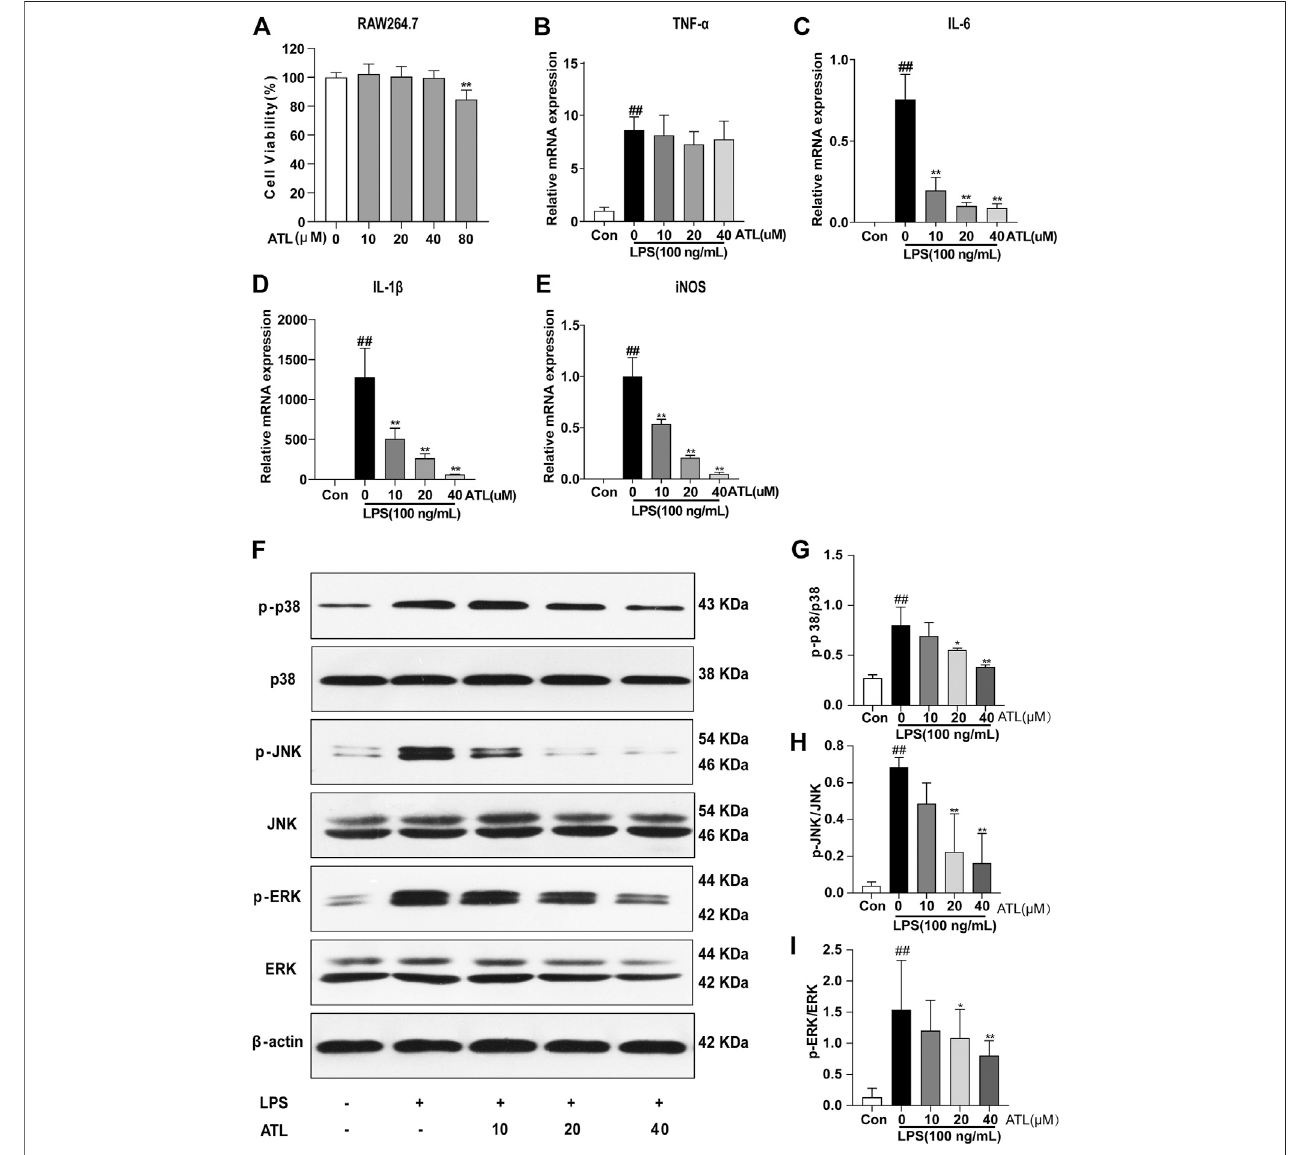
FIGURE 4 | ATL can inhibit the MAPK pathway and expression of in fl ammatory factors in macrophages (A) Cell viability of RAW264.7 cells treated without or with different concentrations of ATL (B – E) mRNA levels of tumor necrosis factor alpha (TNF- α ) (B) interleukin 6 (IL-6) (C) , interleukin-1 β (IL-1 β ) (D) and inducible nitric oxide synthase(iNOS) (E) inRAW264.7cellssubjectedtoLPS(lipopolysaccharide)(100 ng/ml)stimulationandATLtreatment (F) Representativewesternblotsofp-p38,p38, p -JNK, JNK, p -ERK, and ERK in RAW264.7 cells (G – I) Relative density of each signaling band was calculated. Data were obtained from three independent experimentsand arepresentedasthemean ± SEM.Datawereanalyzed usingone-wayANOVA, n (cid:1) 3.# p < 0.05,## p < 0.01comparedtothecontrolgroup.* p < 0.05, ** p < 0.01 compared to the LPS (100 ng/ml) + 0 μ M ATL group.